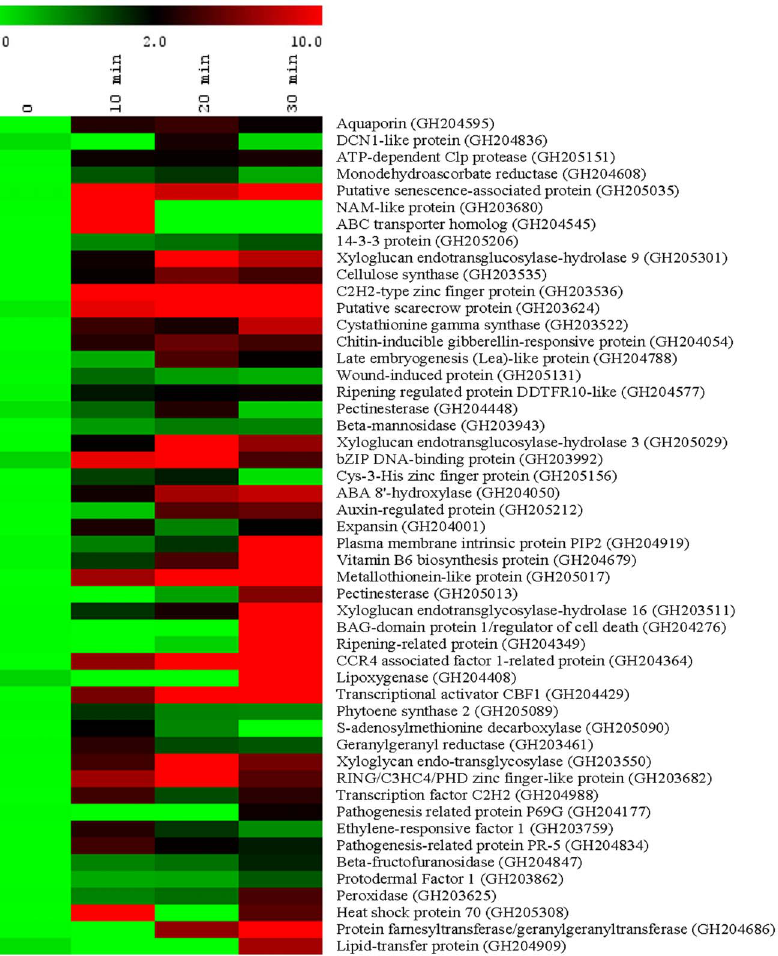
Figure 5. Expression profiles of geraniol-responsive transcripts. Tomato seedlings were treated with 10 mM geraniol and qRT-PCR analysis was carried out for 50 genes selected from SSH library. Data are mean (n=3). Tomato actin was used as endogenous control.